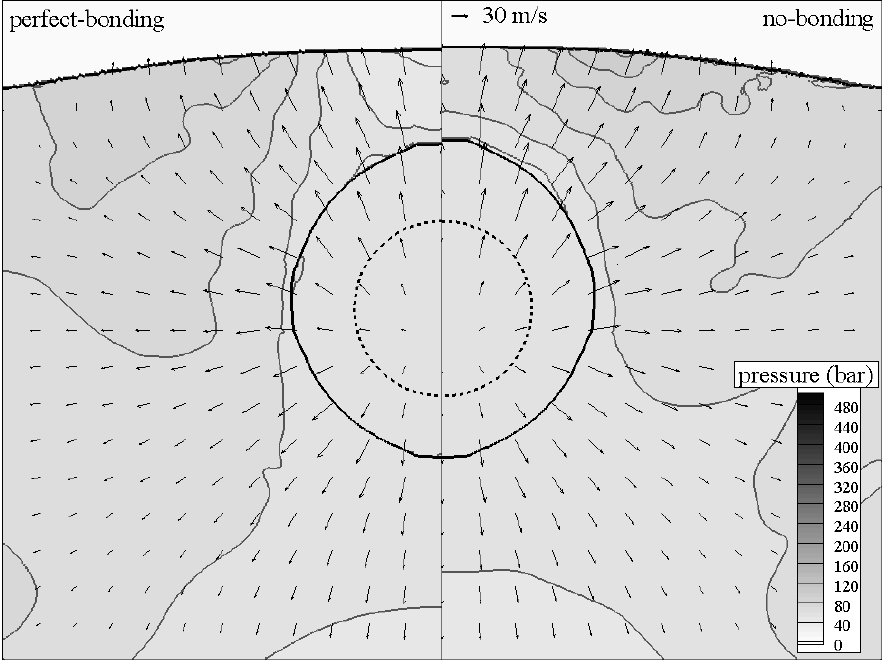
Fig. 14. Comparison of the fluid fields at t = 2 . 4 ms between the perfect- and no-bonding sandwich plates with clamped